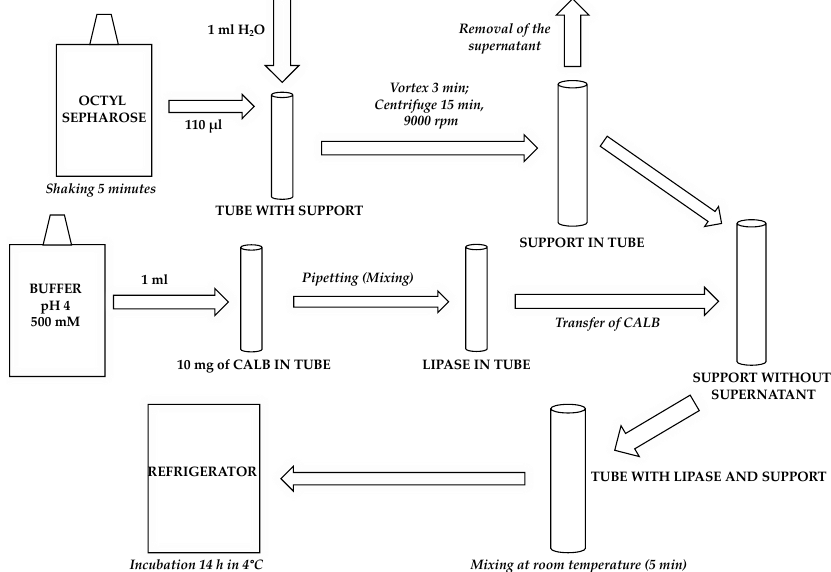
Figure 3. The scheme of the CALB immobilization onto Octyl-Sepharose CL-4B support.